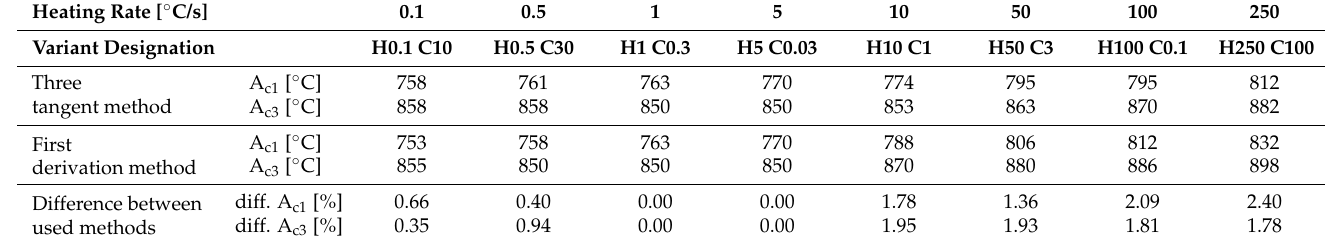
Table 6. The effect of the heating rate on shifts in the transformation temperatures A c1 and A c3.